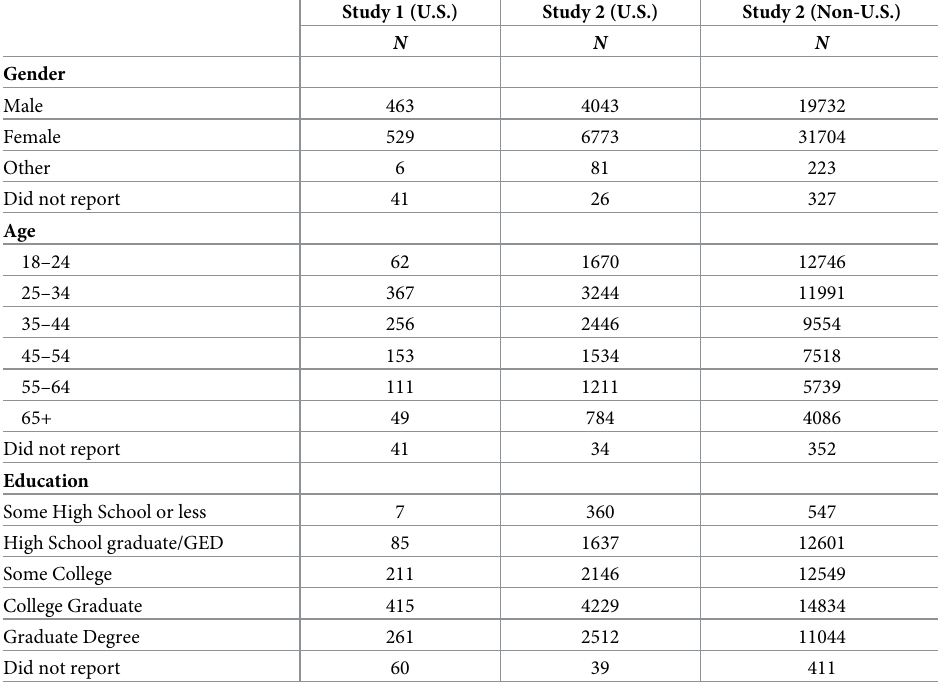
Table 1. Demographic information at baseline for participants in Studies 1 and 2. Study 1 (U.S.) Study 2 (U.S.) Study 2